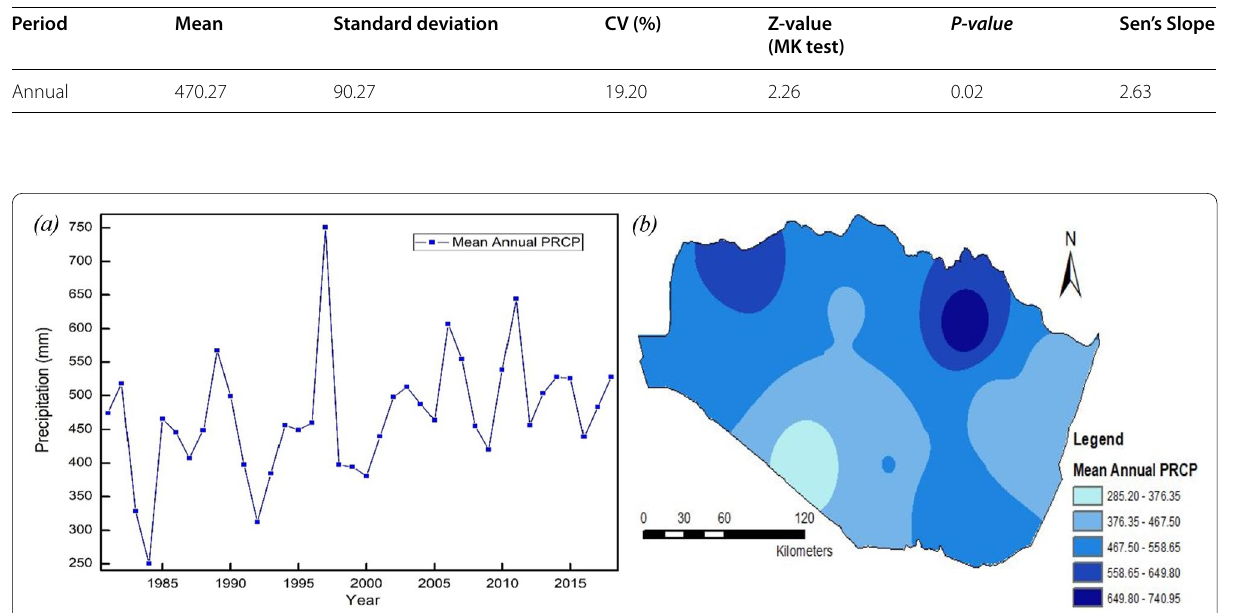
Fig. 9 Mean annual rainfall trend ( a ) and spatial variation ( b ) in the semi-arid Borana (1981–2018)